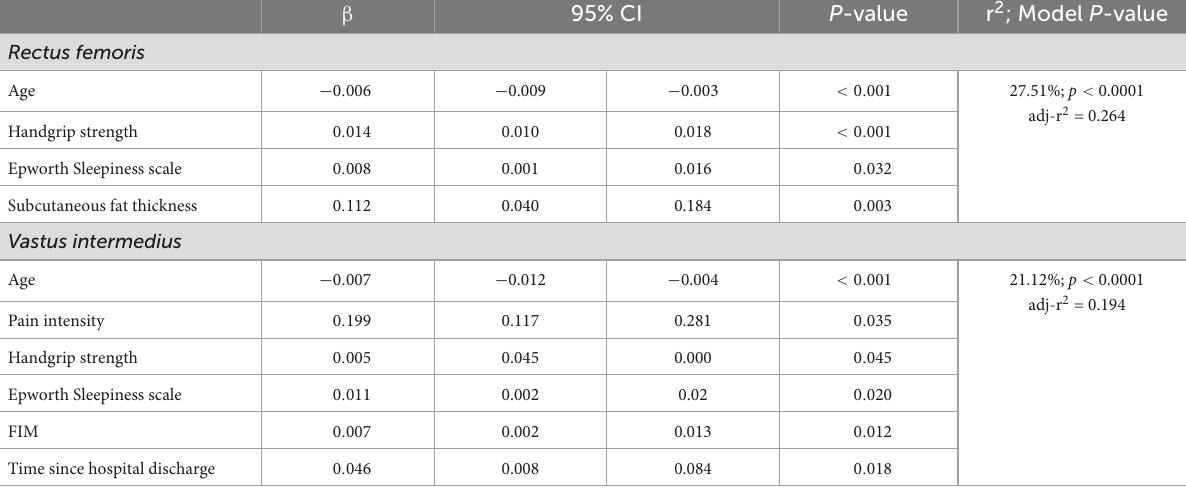
TABLE 3 Best regression model for muscle thickness prediction of rectus femoris and vastus intermedius